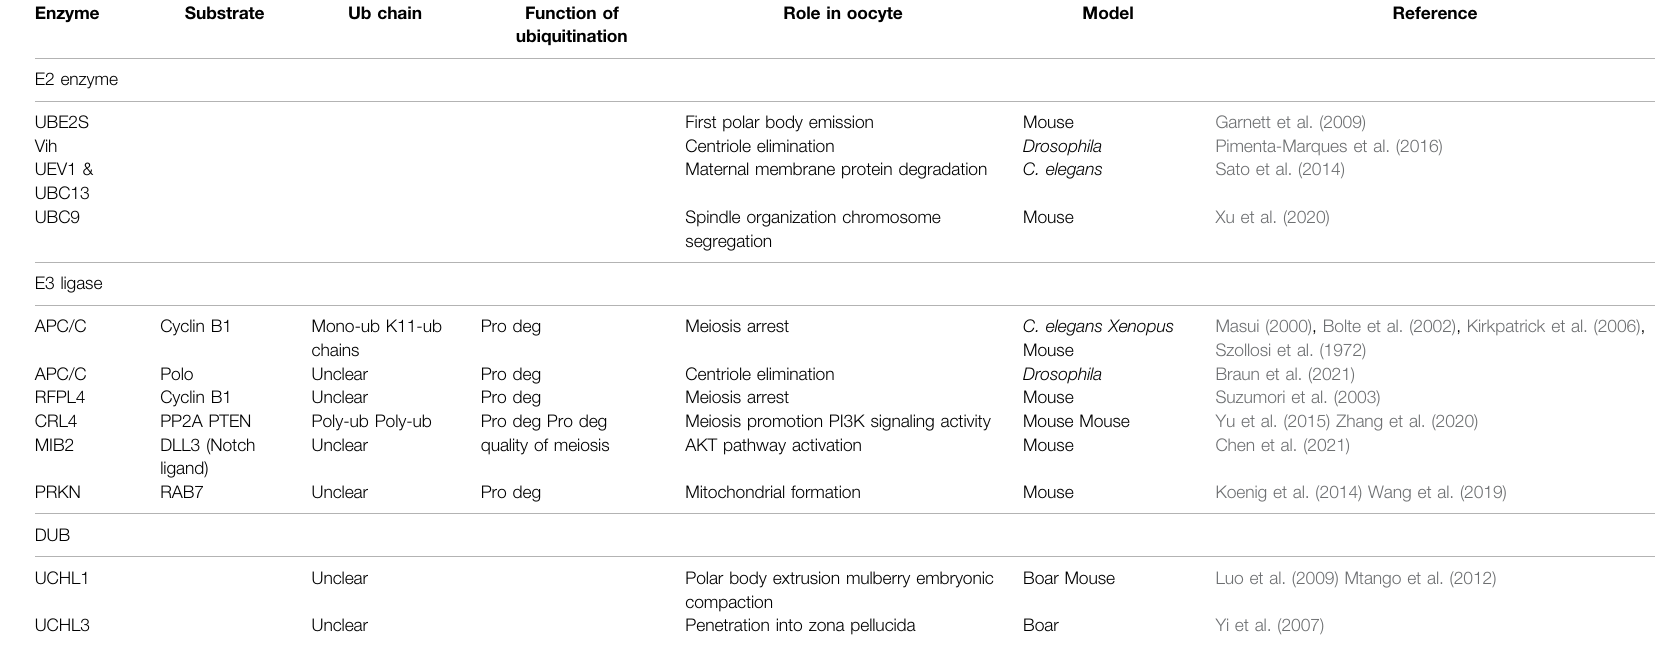
TABLE 2 | Ubiquitination and deubiquitination machinery and targeted substrates work to regulate oocyte development and function.